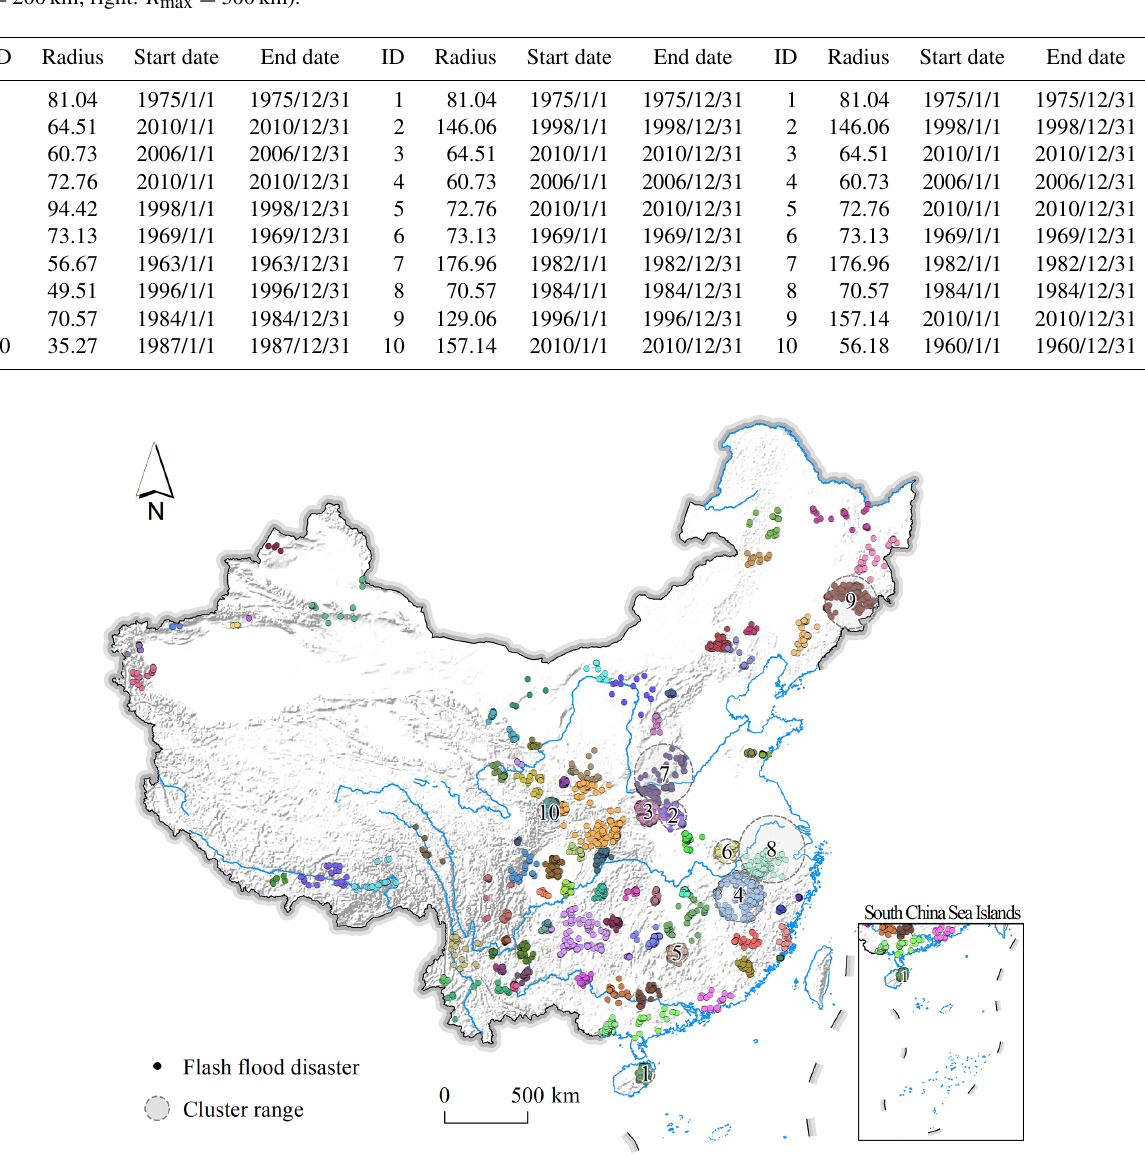
Figure 5. Significant ( p < 0 . 005) spatiotemporal clusters of flash flood disasters occurring in China during 1950–2015 ( R max = 200km, T max = 3 years, T agg = 3